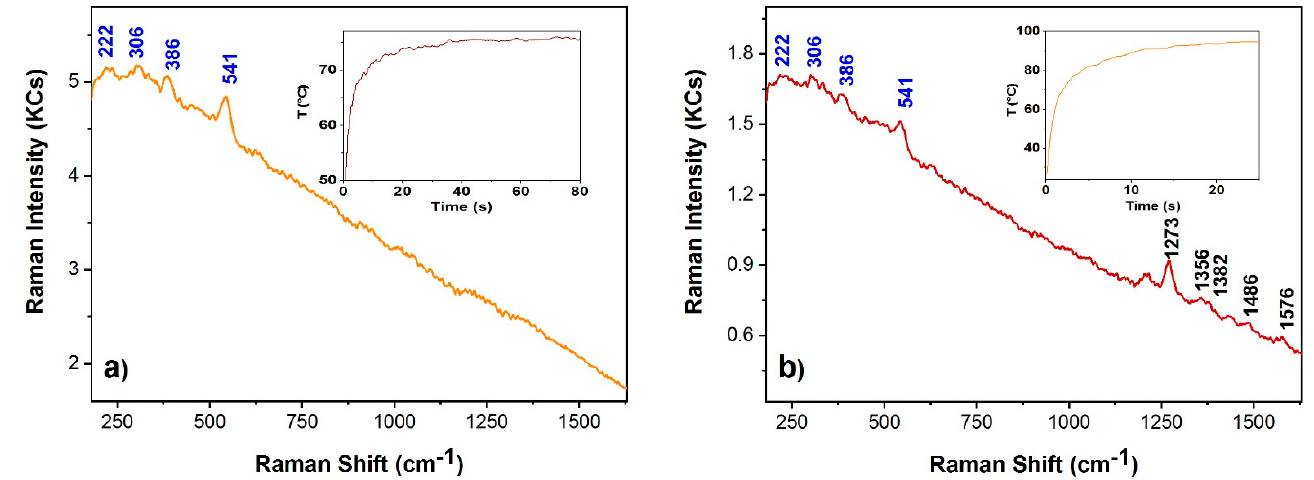
Figure 10. Raman spectra (exc. wav. 785 nm) of light red (( a ) orange line) and red (( b ) wine line) shaded zones (sites A and B, respectively) using 47 mW ( a ) and 22 mW ( b ), respectively. Blue wavenumbers correspond to red lead bands while black wavenumbers highlight the quinacridone bands. The insets show the corresponding temperature profiles, based on measured emissivity of 0.91 ( a ) and 0.87 ( b ), respectively.